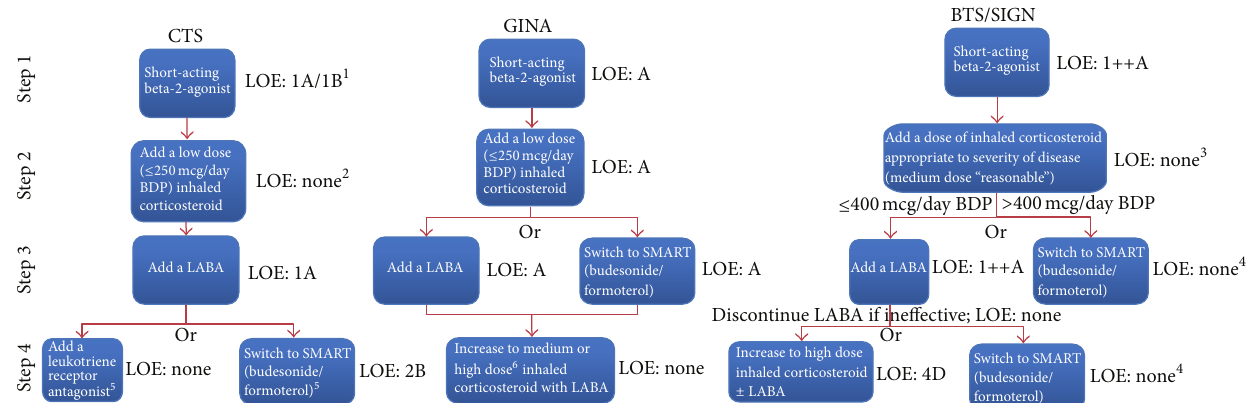
Figure 1: Recommended therapeutic escalation steps and levels of evidence, by guideline. (1) 1A when compared to a LABA; 1B when compared to a LABA/ICS combination. (2) Although it reports an extensive literature review for the recommendation to escalate from a low dose ICS by adding a LABA in step 3 (as opposed to increasing to a medium ICS dose or adding an LTRA), the CTS guideline does not provide a level of evidence nor any reference for initiation at a low ICS dose per se. (3) The BTS/SIGN guideline did not provide a level of evidence nor references for the higher dose approach. In a separate section, authors acknowledged that many patients will benefit more from add-on therapy than from increasing doses above 200 mcg/d BDP. (4) This was an alternative treatment option described in the text only, with no specific level of evidence. (5) The CTS guideline stated that patients uncontrolled on a fixed-dose ICS/LABA should be switched to the SMART approach in lieu of increasing the ICS dose of the combination. However, in a separate section, the guideline also noted that “if asthma remains uncontrolled on the combination of an ICS and LABA . . . consider the addition of an LTRA,” suggesting that either switching to the SMART approach or adding an LTRA would be acceptable. (6) The GINA guideline stated that an increase from medium to high dose provides “relatively little additional benefit,” which seems to contradict the BTS/SIGN approach in both this step and in step 2. See Appendix for a description of the evidence rating system used by each guideline. BDP denotes beclomethasone dipropionate; BTS/SIGN denotes British Thoracic Society/Scottish Intercollegiate Guidelines Network; CTS denotes Canadian Thoracic Society; GINA denotes Global Initiative